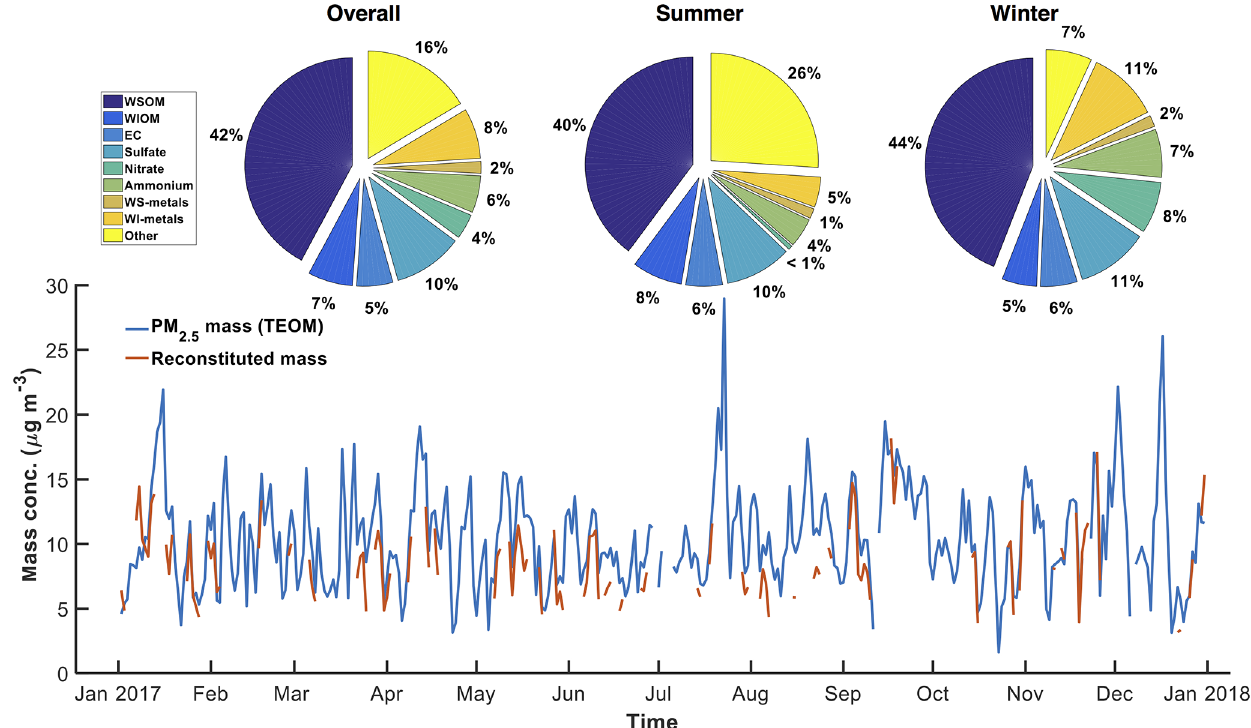
Figure 1. Time series of PM 2 . 5 mass concentration. The pie charts show the average aerosol composition based on PM 2 . 5 mass measured by the tapered element oscillating microbalance (TEOM) during the whole sampling year, summer, and winter. WSOM is water-soluble organic matter ( = WSOC × 1 . 6); WIOM is water-insoluble organic matter ( = OM − WSOM); WS-metals is the sum of water-soluble metals, including Al, Mg, Ca, K, Fe, Cu, Mn, Zn; and WI-metals are water-insoluble metals ( = total_metals–WS_metals). Summer is June–August, and winter is January–February and November–December.